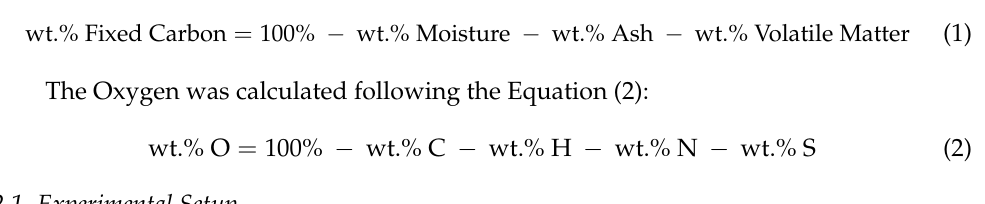
Table 1. Properties of pine wood pellets. Analysis